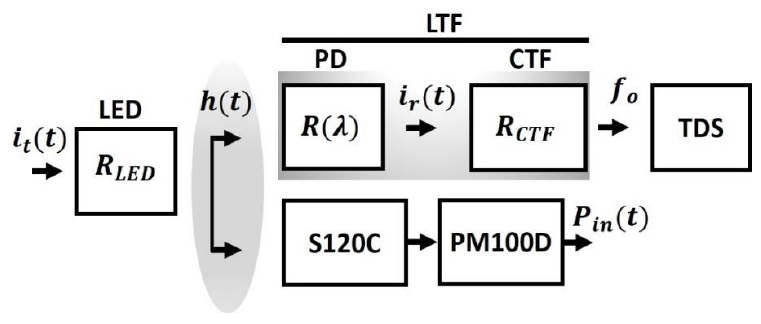
Figure 2. Experimental setup for the characterization of the LTF converter.